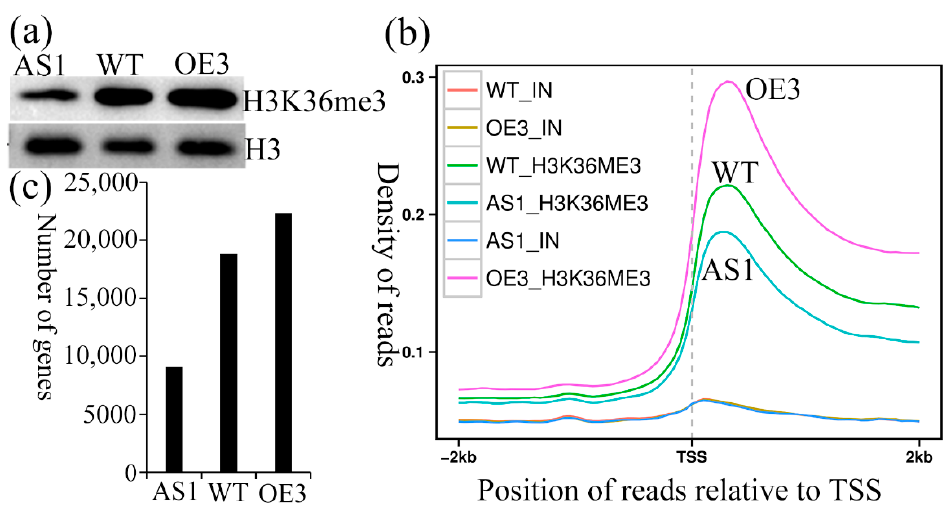
Figure 5. The perturbation of the SDG102 expression induced global changed H3K36me3 in SDG102 knockdown (AS1) and overexpression (OE3) plants vs. the wild-type (WT). ( a ) Western blot analysis. ( b ) The gene aggregation plots for H3K36me3. ( c ) The total number of genes with H3K36me3. TSS = transcription termination site.